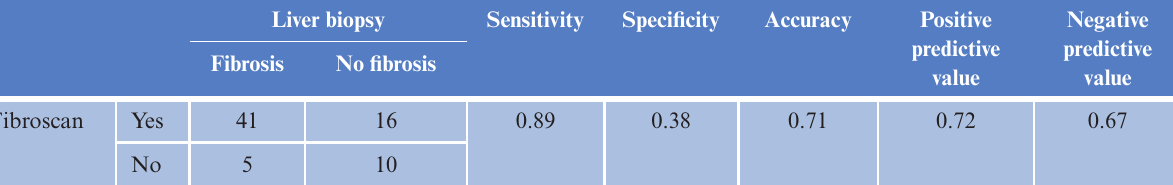
Table 3: Diagnostic analysis of Fibroscan with liver biopsy Liver biopsy